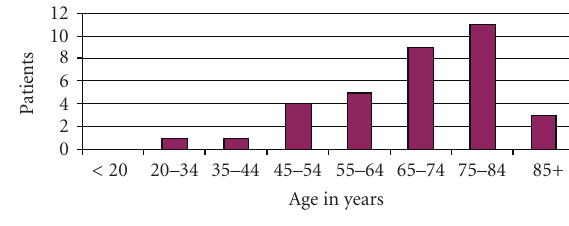
Figure 1: Distribution according to age. Table 1: Macroscopic characteristics of the lesions.